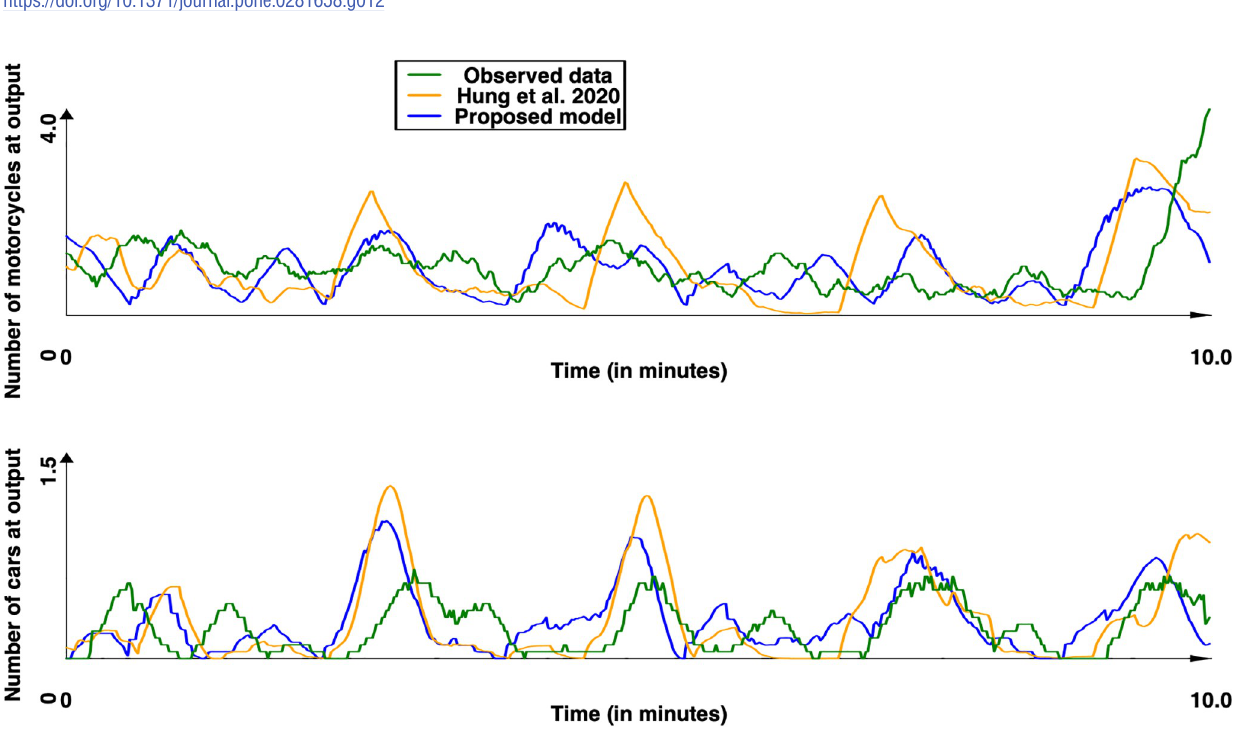
Fig 13. Observed and simulated results (with [44] and our models) for the Chua Boc site. Motorcycle and car counts—mean of the simulation (time series were smoothed out using moving average with a window size of 10s.